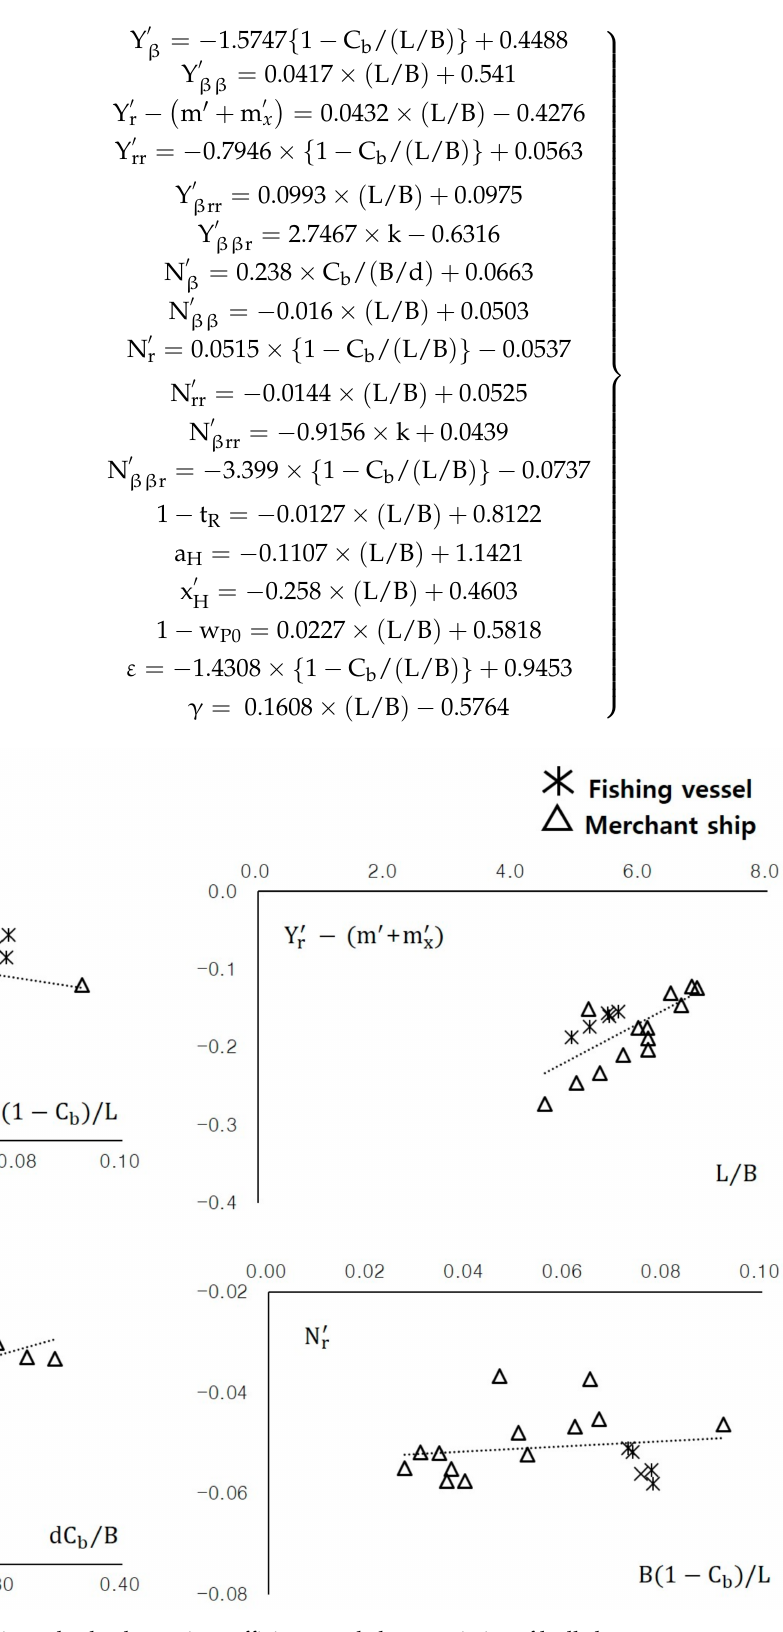
Figure 4. Trend line of correlation between linear hydrodynamic coefficients and characteristics of hull shape